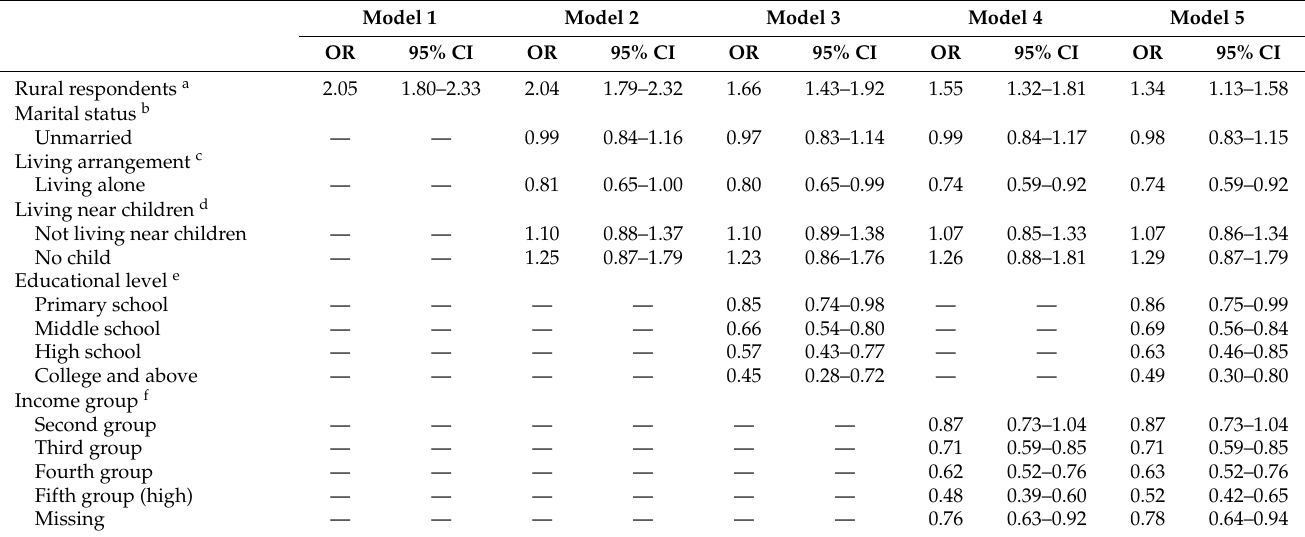
Table 5. Multiple logistic regression analyses on rural and urban respondents’ poor Self-Rated Health (SRH), adjusted for age and sex, CHARLS 2011 ( n = 6003).